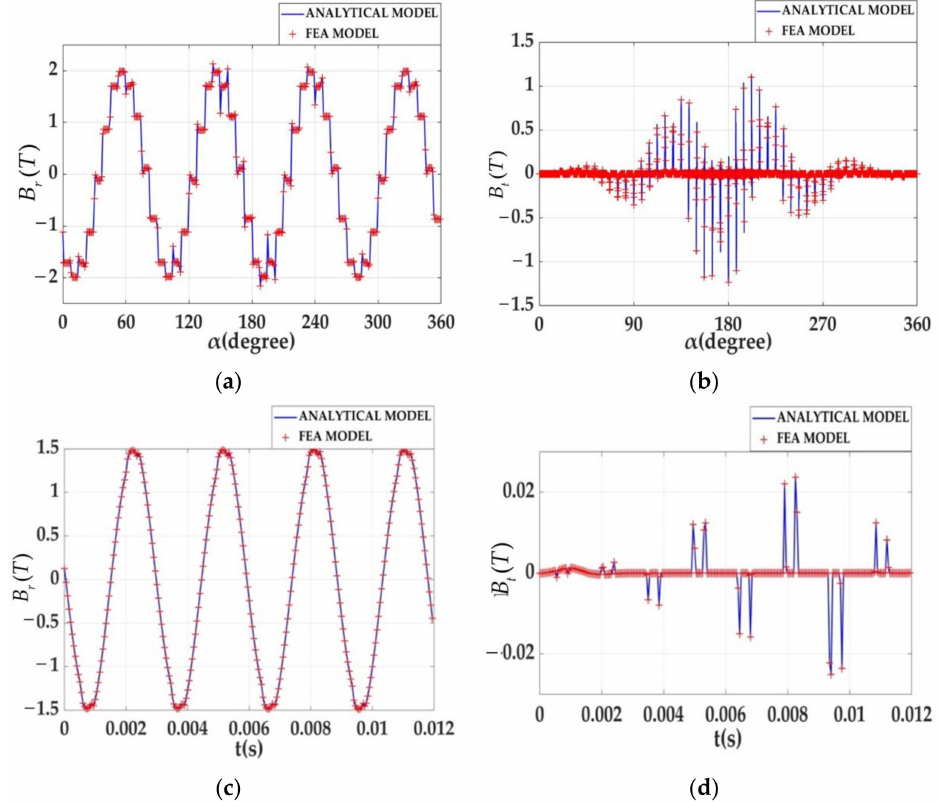
Figure 5. The spatial and temporal distributions of air-gap flux density with mixed eccentricity. ( a ) The spatial distribution of radial flux density; ( b ) The spatial distribution of tangential flux density; ( c ) The temporal distribution of radial flux density; ( d ) The temporal distribution of tangential flux